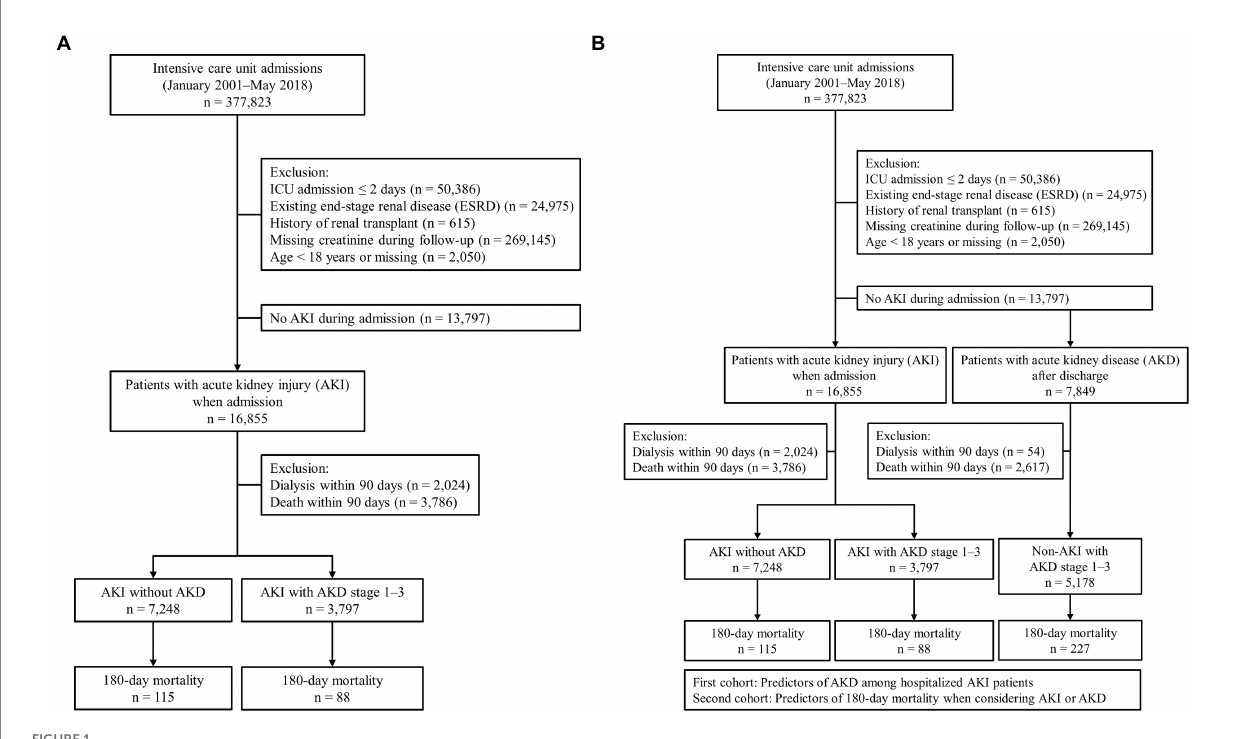
FIGURE 1 Flowchart showing the study protocol. (A) First cohort and (B) second